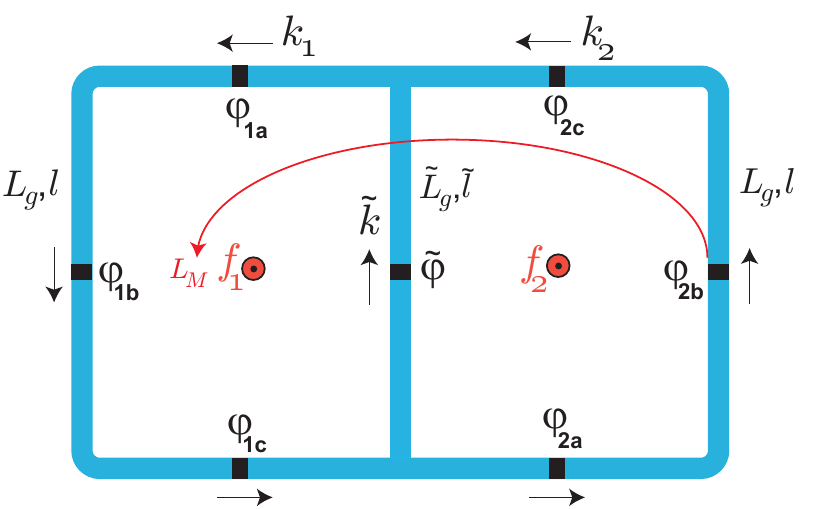
Figure 1. Two superconducting flux qubits are coupled through a common branch with the self- inductance ˜ L g and length ˜ l . L g is the self-inductance of the left and right branch with length l , and L M is the mutual inductance between the left(right) qubit loop and the right(left) branch with length l . ϕ ’s are the phase differences of Josephson junctions, and k ’s are the wave vectors of Cooper